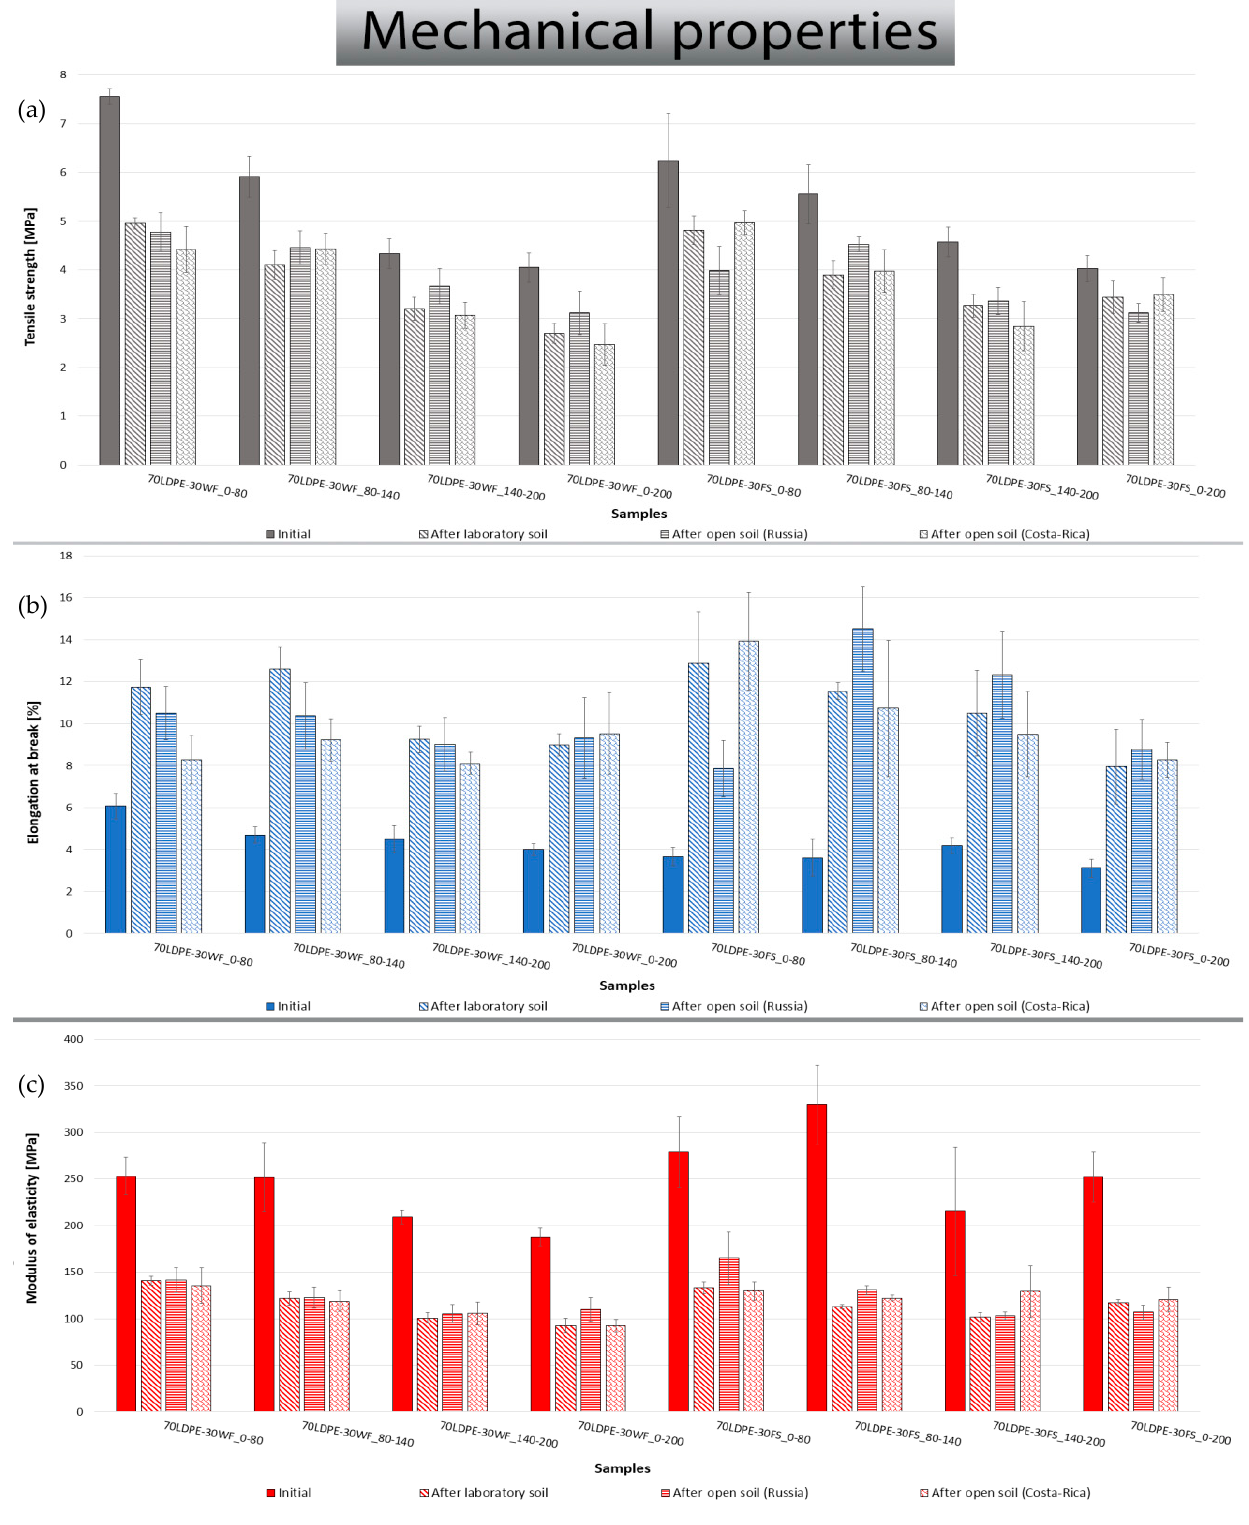
Figure 4. Tensile strength ( a ), elongation at break ( b ) and modulus of elasticity ( c ) of biocomposites before and after biodegradation tests.